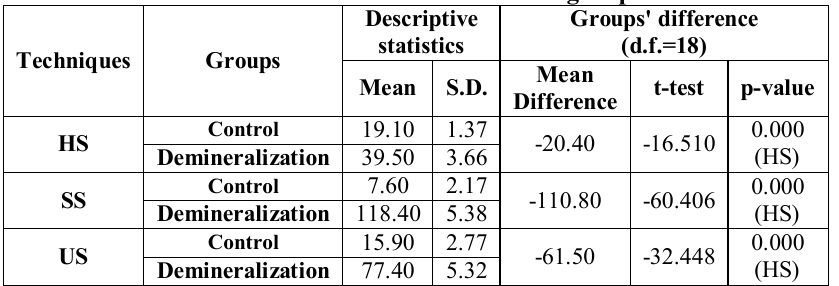
Table 1: Effect of demineralization on Enamel damage depth (μm.) and comparing the effect of demineralization with the control group.